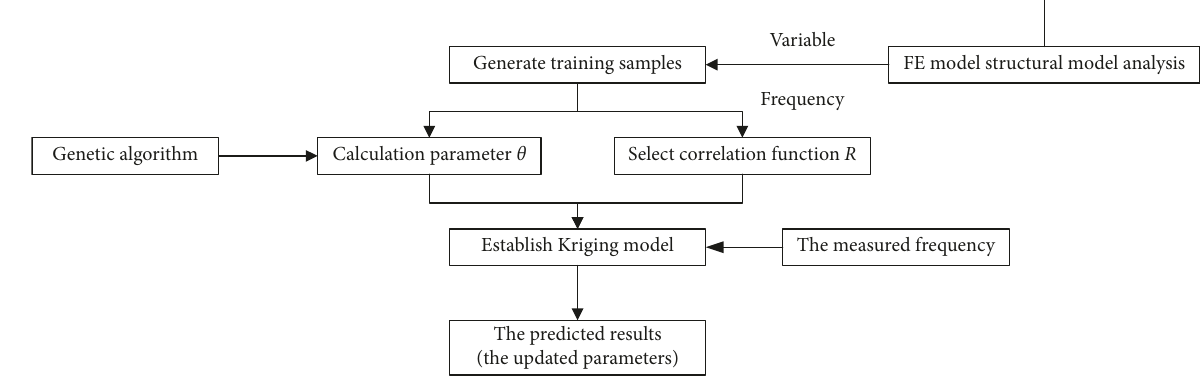
Figure 4: Flowchart of the Kriging model.